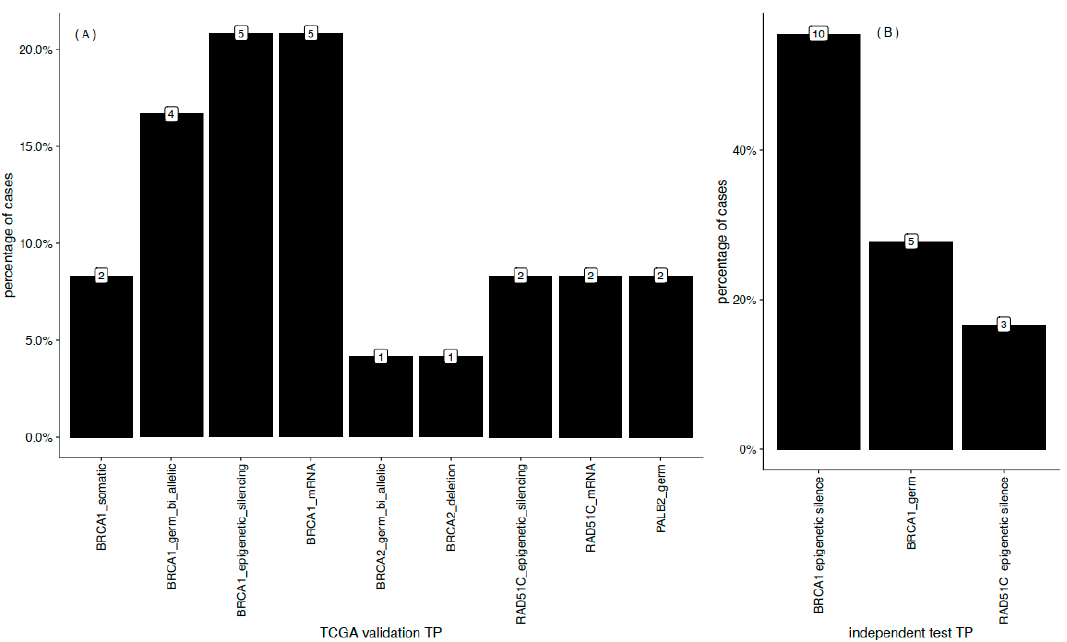
Figure 5. HR (homologous recombination)-associated molecular drivers. The distribution of lesions in known HR-pathway genes of the MMRD predicted patients among the training ( A ) and independent cohorts ( B ). Numbers above each bar count the patients for the corresponding lesion.